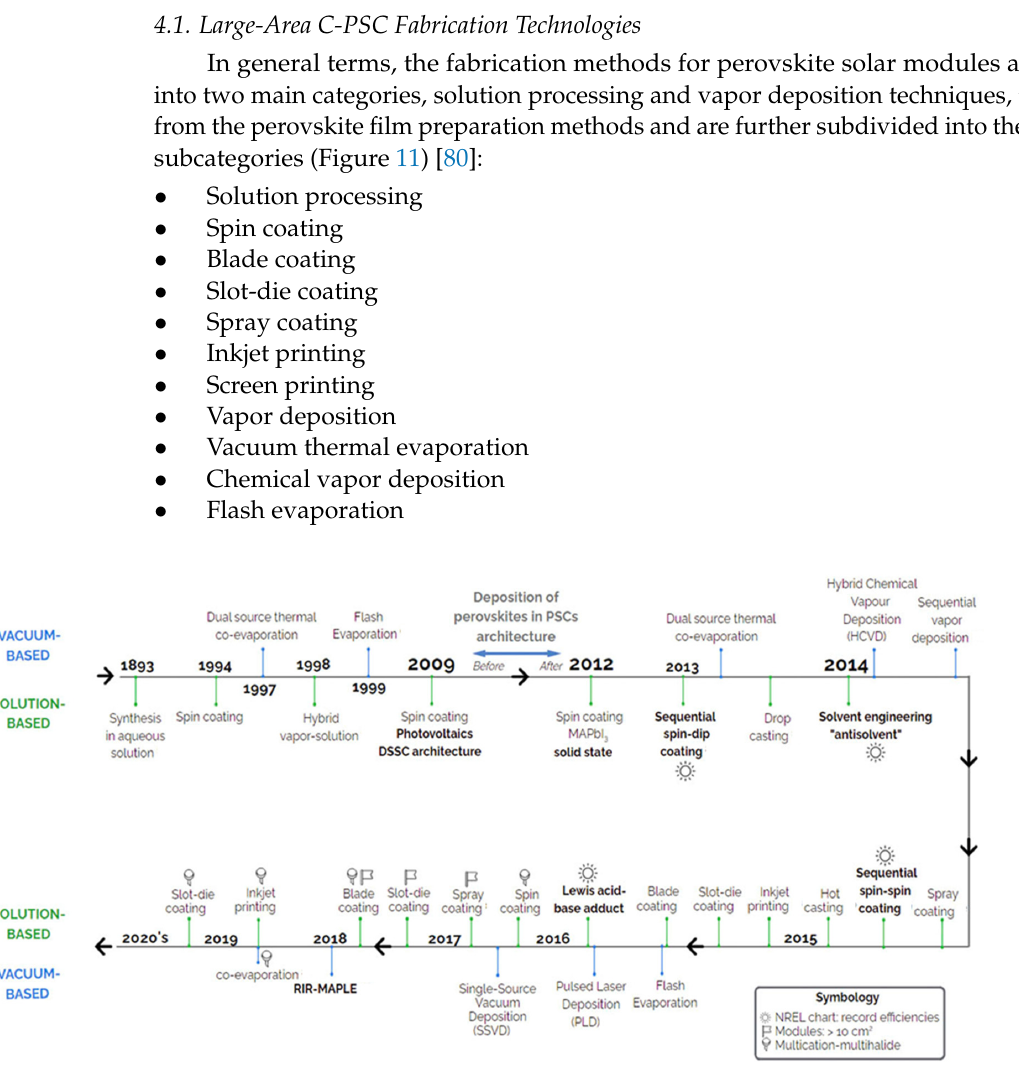
Figure 11. Timeline of the development of thin-film fabrication methods for inorganic and hybrid halide perovskites. The methods are classified into vacuum-based vs. solution-based. The symbols described in the inset indicate which methods were used for the fabrication of modules, multication– multihalide compositions and reported NREL record efficiencies [80]. (Reproduced from Ref. [80], 10.1063/5.0027573, with